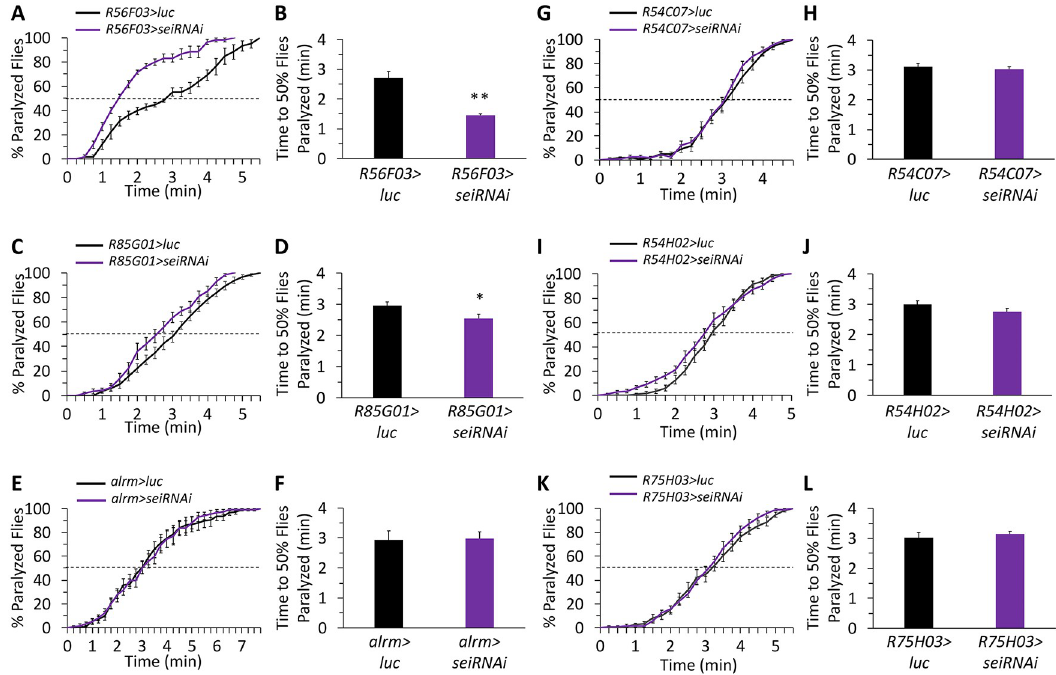
Fig 6. Organismal response to acute heat stress depends on sei action in neuropile ensheathing and perineurial glia. Glia subtype specific RNAi-dependent sei knockdown screen. A-B ) Neuropile ensheathing glia ( R56F03-GAL4 ) n = 6 vials/genotype; C-D ) Perineurial glia ( R85G01-GAL4 ) n = 12; E-F ) Astrocyte-like glia ( alrm-GAL4 ) n = 12; G-H ) Subperineurial glia ( R54C07- GAL4 ) n = 12; I-J ) Cortex glia ( R54H02-GAL4 ) n = 12; K-L ) Tract ensheathing glia ( R75H03-GAL4 ) n = 12. All experiments conducted with 10 flies per vial, placed in 41–42˚C water. Data are presented as mean ± SEM, � p < 0.05, �� p < 0.01 (Student’s t -test).